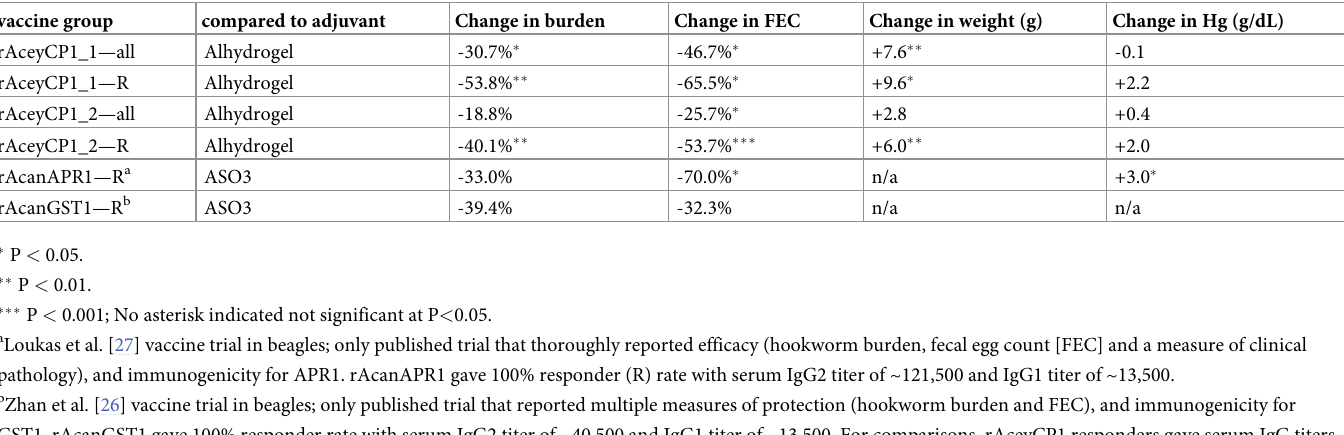
Table 1. Summary of the mean efficacy results from rAceyCP1/Alhydrogel vaccine trials and comparison to clinical hookworm antigen candidates. vaccine